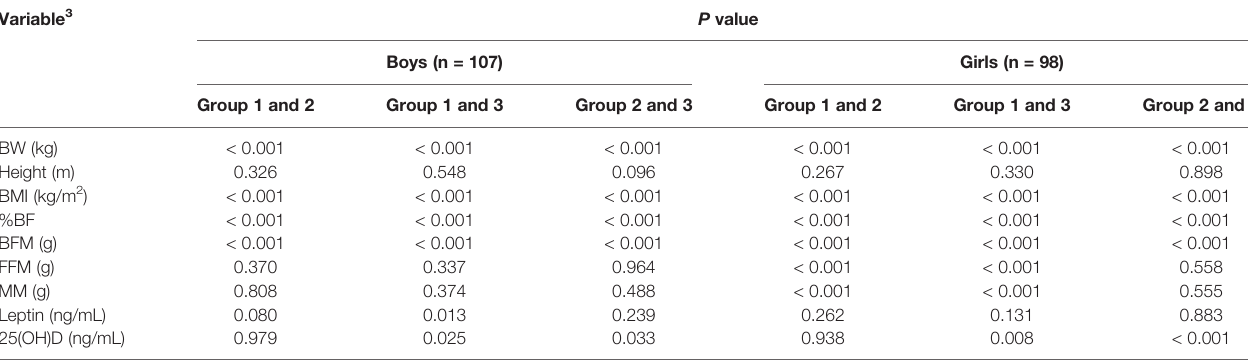
TABLE 2 | Comparisons 1 of the variables between %BF groups 2 of boys and girls. Variable 3